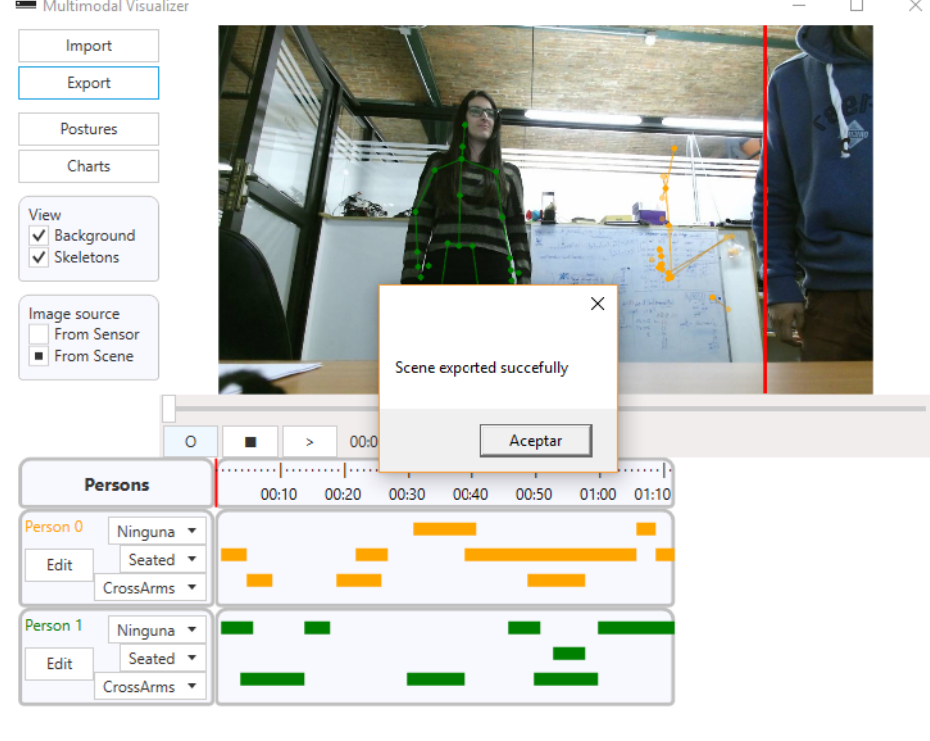
Figure 3. Screenshot of Lelikëlen application showing the postures detected for two